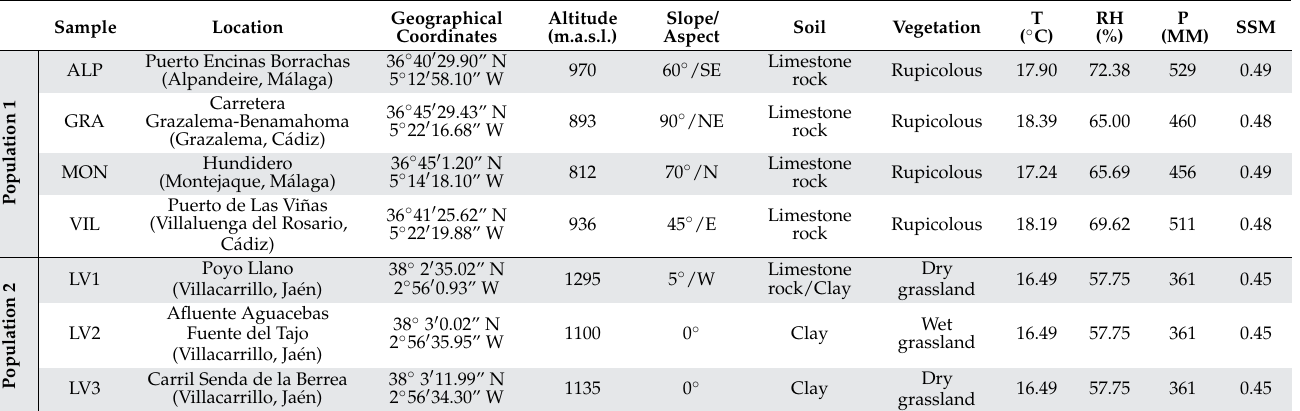
Table 1. C. reverchonii samples collected and ecological conditions of sampling